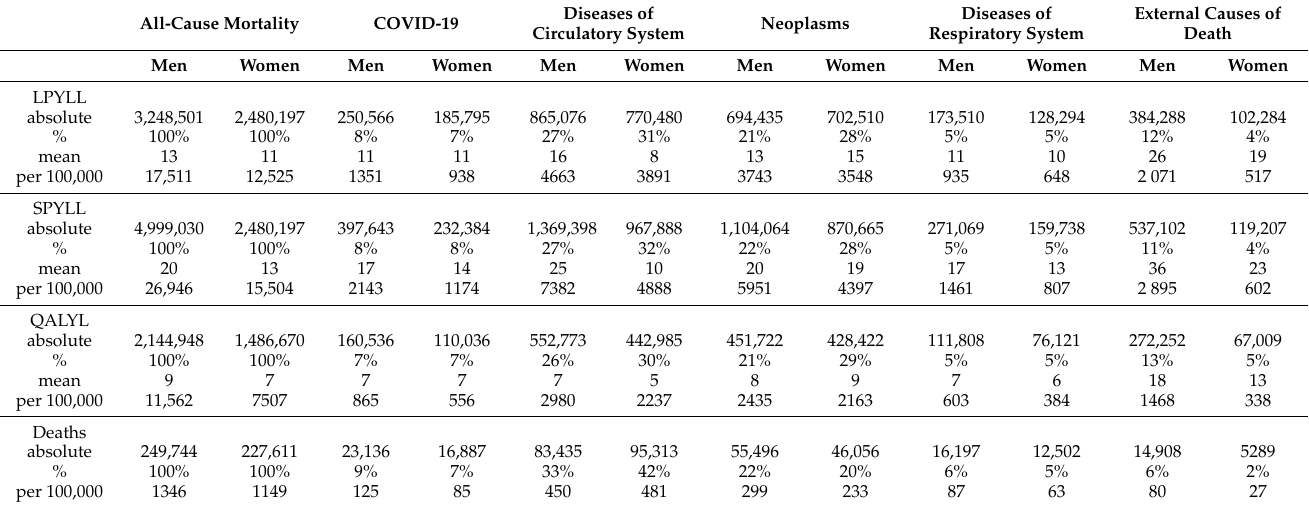
Figure 3. Quality adjusted years of life lost (QALYL) among people with COVID-19 in Poland in 2020 by age and sex. QALYL—scale on the left, columns; QALYL per 100,000—scale on the right, lines. QALYL caused by COVID-19 morbidity was estimated for 6198,96 (16.14 per 100,000 Table 1. Deaths and disease burden (LPYLL 1 , SPYLL 2 , QALYL 3 ) in Poland in